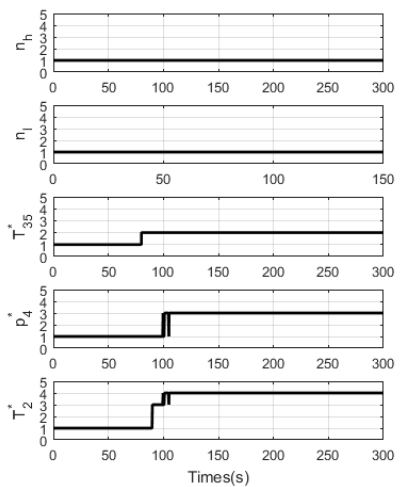
Figure 8. FDI for the scenario of concurrent sensor faults.